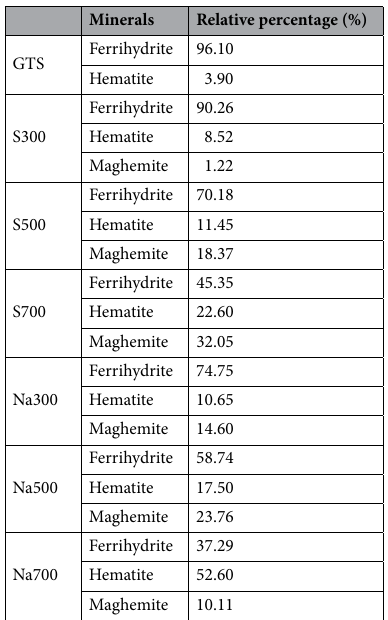
Table 2. Relative content of minerals in Fe oxides of GTS and the treated